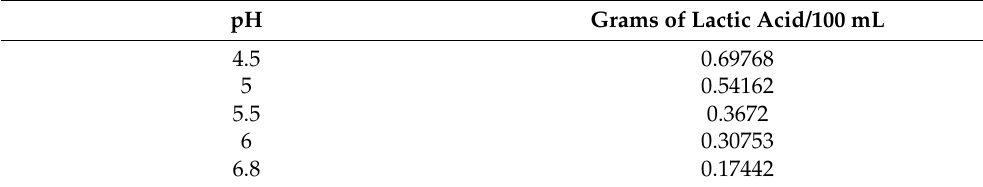
Table 4. Milk pH and acidity values.